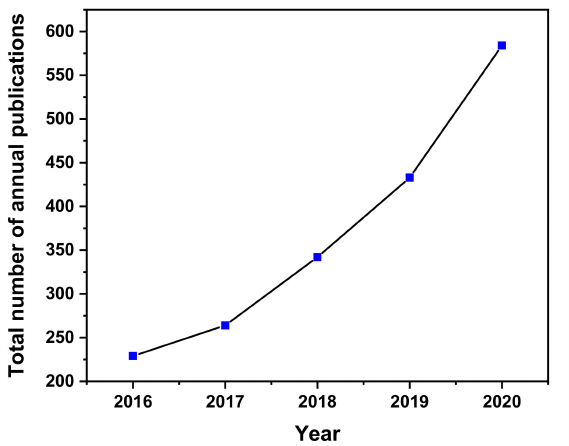
Figure 1. Annual number of publications with the phrase “cyanobacteria for Heavy Metal